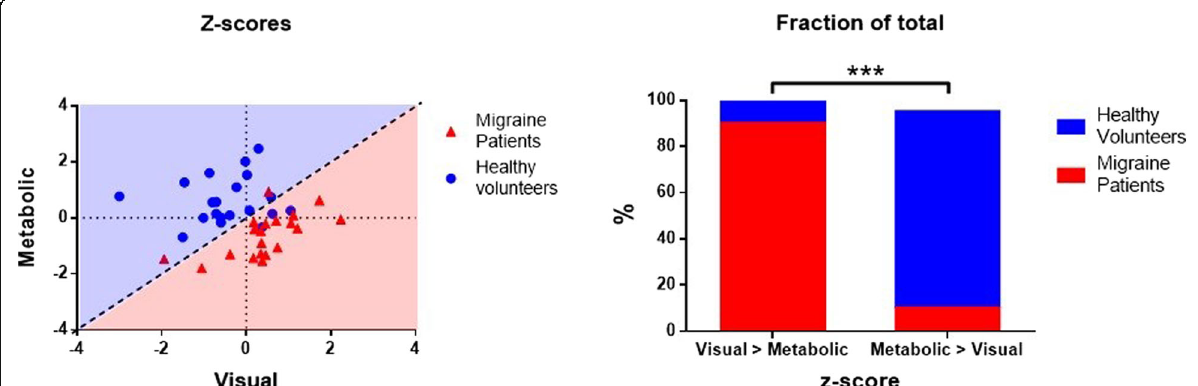
Fig. 3 Left: Metabolic and Visual Z-scores of each participant plotted on a Cartesian coordinates plane. Points above the dashed diagonal line (light blue shaded area) correspond to participants with higher glucose uptake in the visual cortex with respect to their visual responsiveness score. Points below the dashed diagonal line (light red shaded area) correspond to participants exhibiting disproportionally higher visual responses considering their glucose uptake. Right: relative proportion of subjects of each within each side of the dashed diagonal line of the Cartesian plot. The asterisks (***) indicate a p value < 0.001